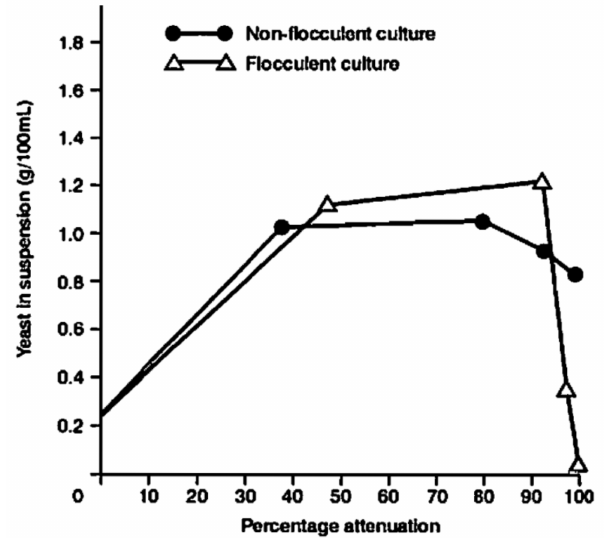
Figure 1. Static fermentation flocculation characteristics [1].